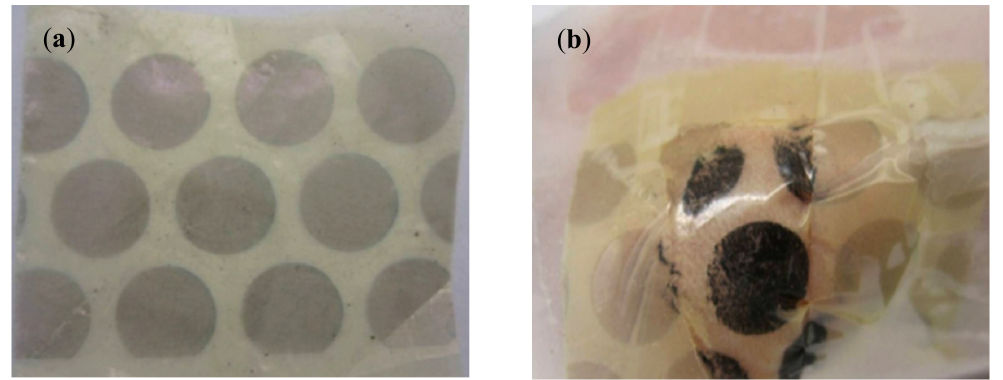
Figure 9. ( a ) A thin filmed H 2 sensor prior to exposure to H 2 ; ( b ) H 2 detected by the film through the mouse’s skin [35].